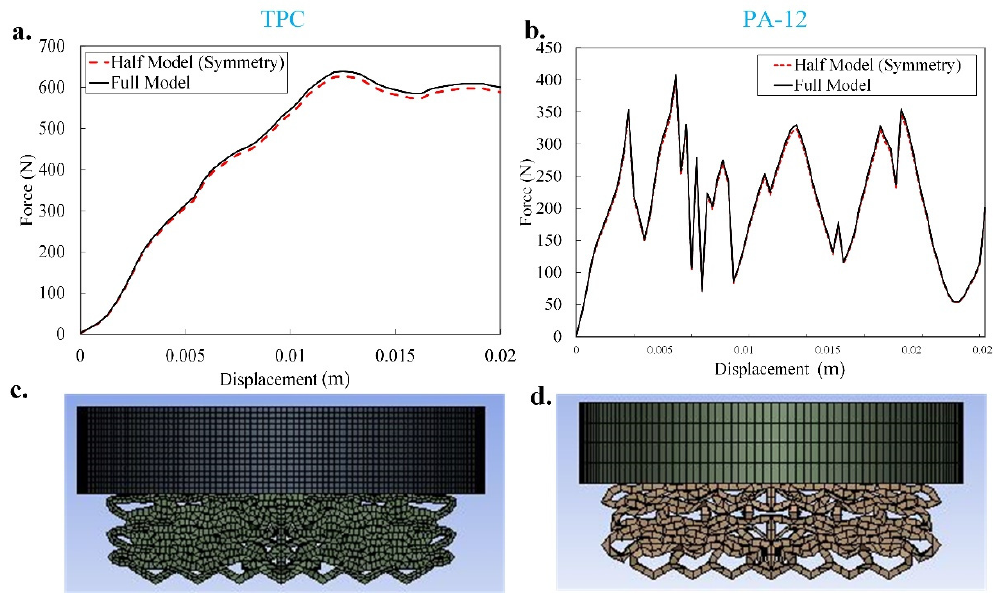
Figure 4. Numerical uniaxial force-displacement response for sample 1 based on ( a ) TPC and ( b ) PA12 in using both the full model and half model (symmetric). The deformed shape of the full model of ( c ) TPC and ( d ) PA12 at the end of loading.